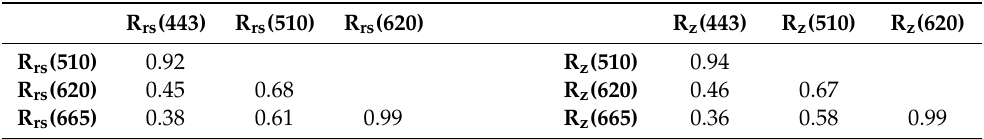
Table 1. Correlation coefficients between simultaneous observations of R rs (443), R rs (510), R rs (620), and R rs (665) (right) and their standardized counterparts R z (443), R z (510), R z (620) and R z (665)